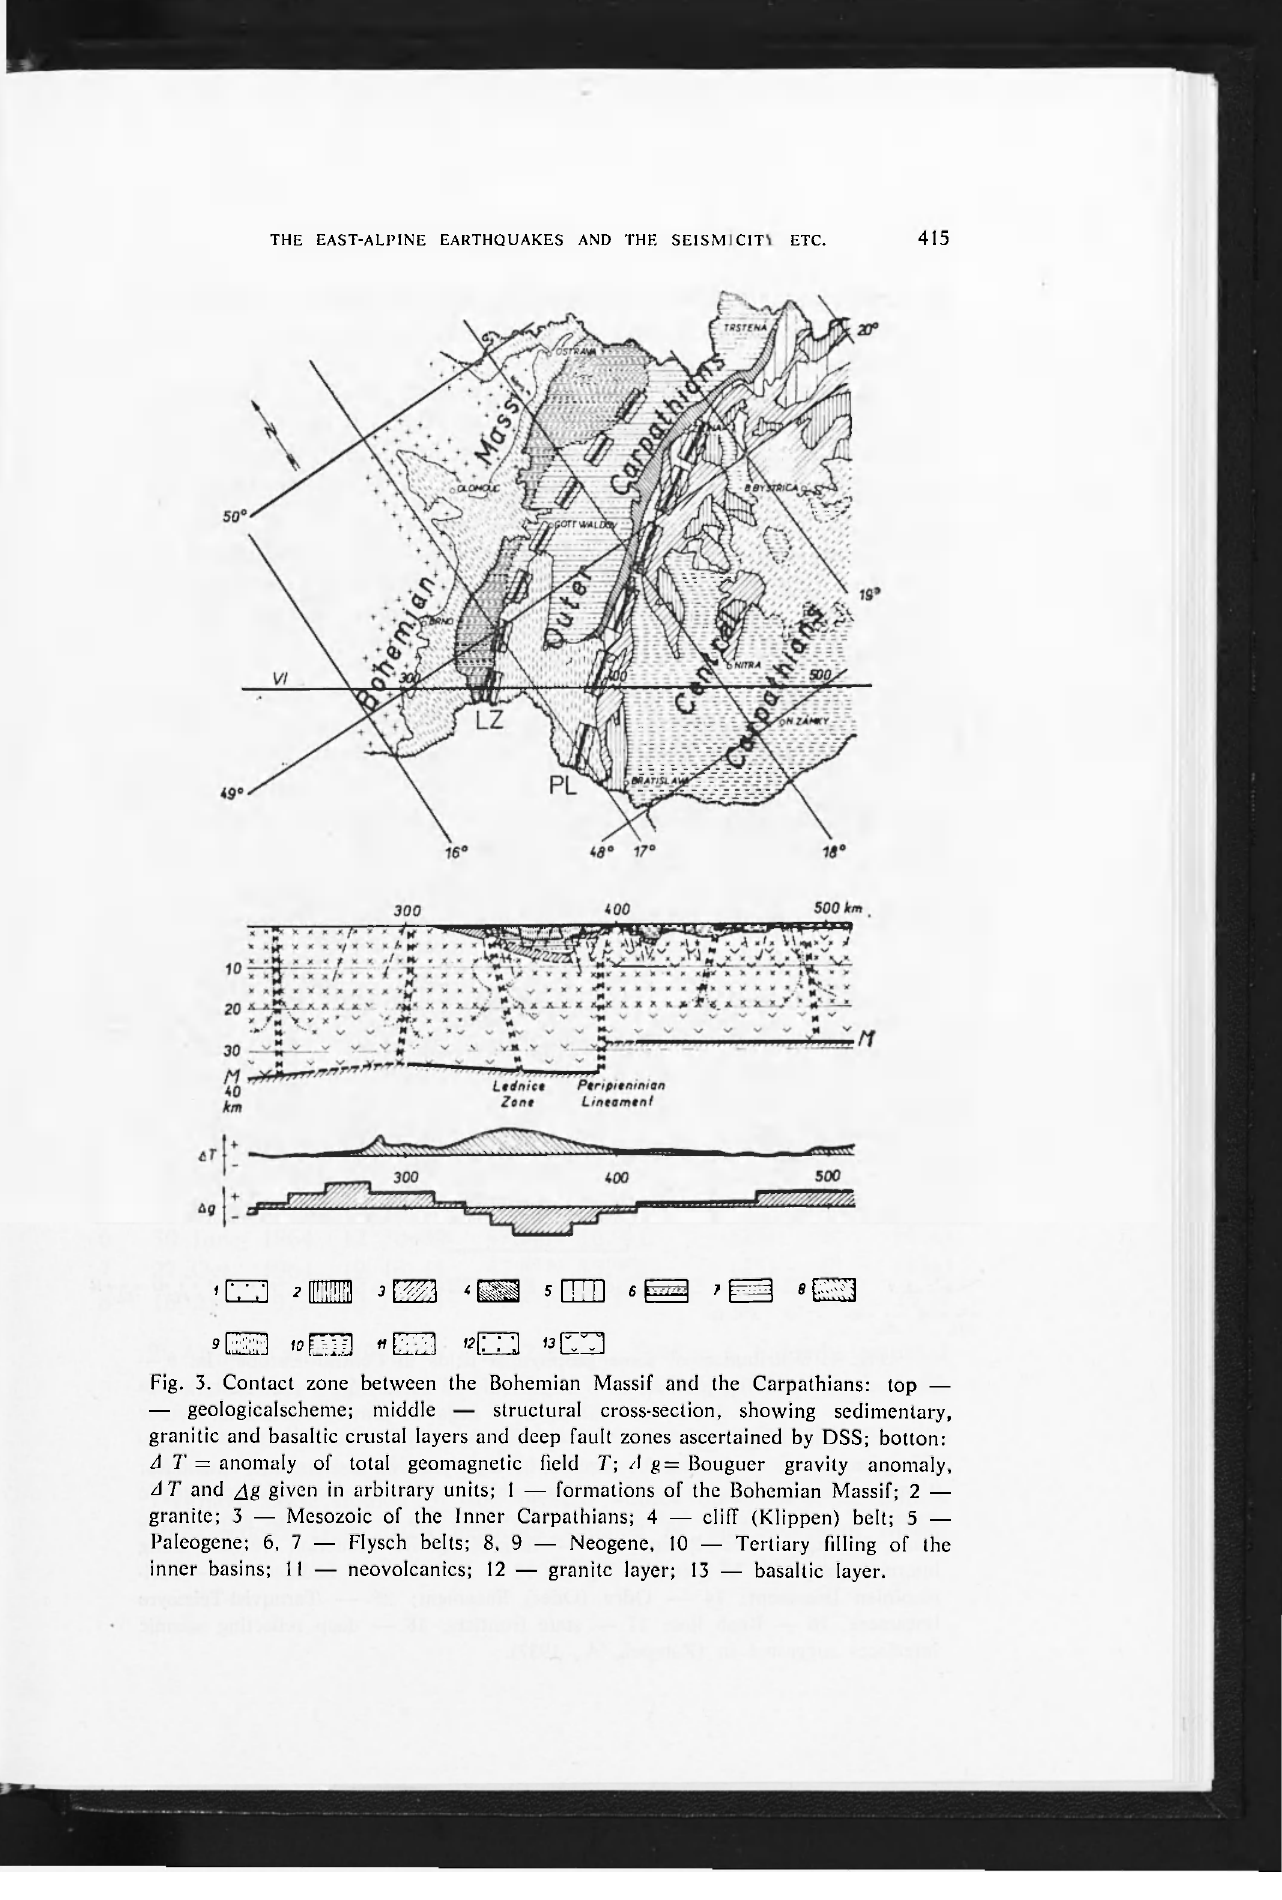
Fig. 3. Contact zone between the Bohemian Massif and the Carpathians: top — — geologicalscheme; middle — structural cross-section, showing sedimentary, granitic and basaltic crustal layers and deep fault zones ascertained by DSS; botton: A T = anomaly of total geomagnetic field T; A g= Bouguer gravity anomaly, A T and given in arbitrary units; 1 — formations of the Bohemian Massif; 2 — granite; 3 — Mesozoic of the Inner Carpathians; 4 — cliff (Klippen) belt; 5 — Paleogene; 6, 7 — Flysch belts; 8, 9 — Neogene, 10 — Tertiary filling of the inner basins; 11 — neovolcanics; 12 — granite layer; 13 — basaltic